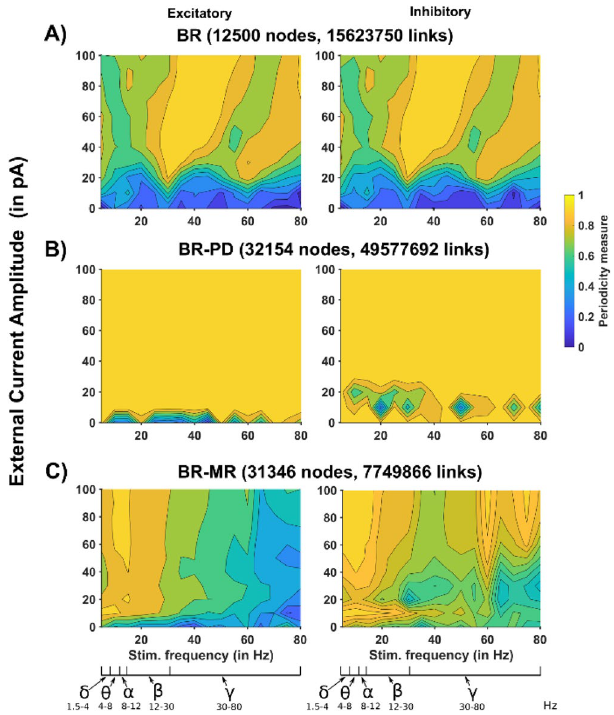
Figure 5. Cosine distance as a function of external stimulation amplitude and frequency. (Left) Excitatory neurons, (Right) Inhibitory neurons. ( A ) A 12,500-neuron network connected as in BR 14,34 , ( B ) connected as in PD 33 with 30,000 neurons, ( C ) connected as in MR 30 with 30,000 neurons. Major brain rhythm ranges (from Buzsáki and Draguhn 35 ) are shown below the stimulation frequency